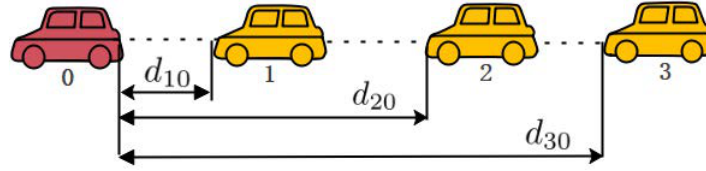
Figure 2. The vehicle platoon control scheme.